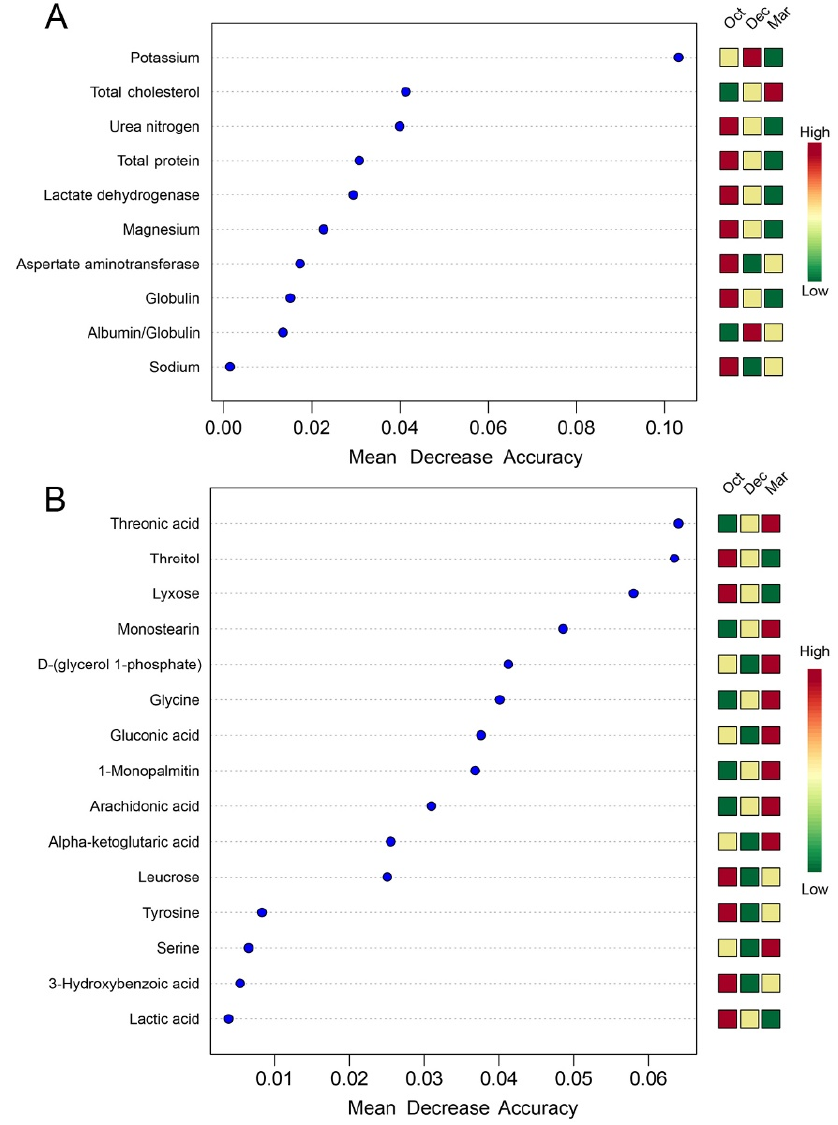
Figure 4. Random forest models of ( A ) serum indices with significant differences and ( B ) differential serum metabolites in grazing yaks during the cold season. Only the indices with a false discovery rate (FDR) < 0.05 are presented in the figures.